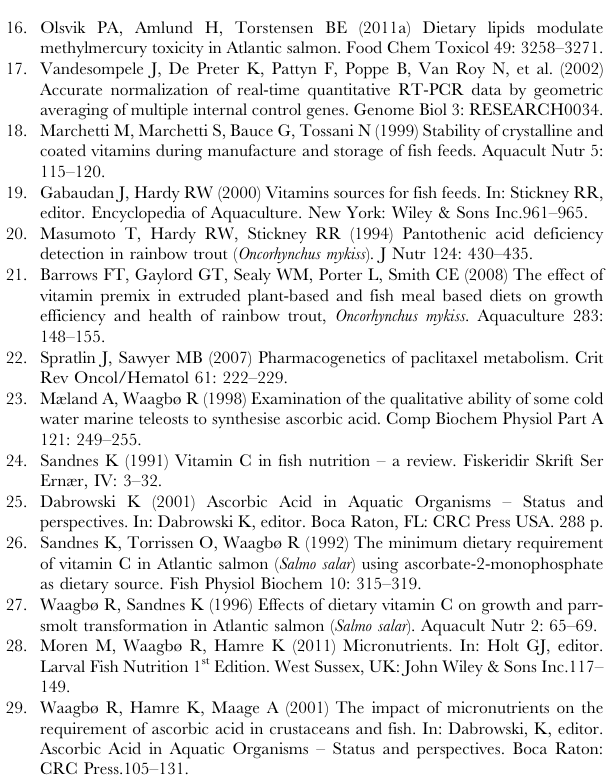
Table S1 Transcripts up-regulated in liver of rainbow trout by diet U. Table S2 Transcripts down-regulated in liver of rainbow trout by diet